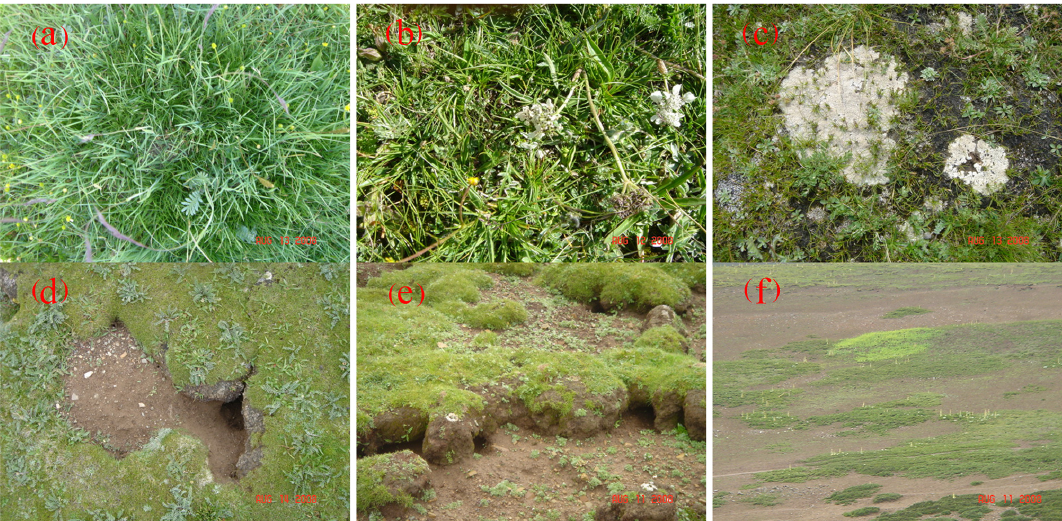
Figure 2. The degradation succession of Tibetan alpine Kobresia grasslands was divided into six stages: (a) the Gramineae grass– K. humilis community (stage I), (b) the K. humilis community (stage II), (c) the thickening in mattic epipedon of the K. pygmaea community (stage III), (d) the cracks in mattic epipedon of the K. pygmaea community (stage IV), (e) the collapse in mattic epipedon of the K. pygmaea community (stage V), and (f) the forbs–black-soil beach (stage VI). Table 1. Detailed information about the six degradation successional stages of alpine Kobresia